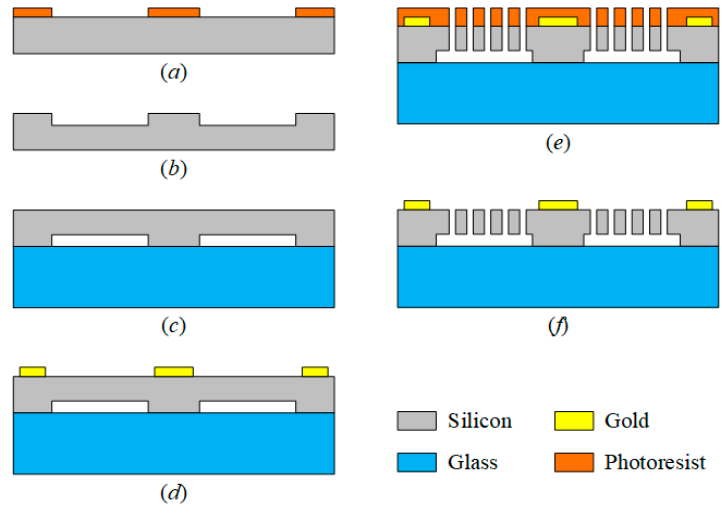
Figure 10. Fabrication process.